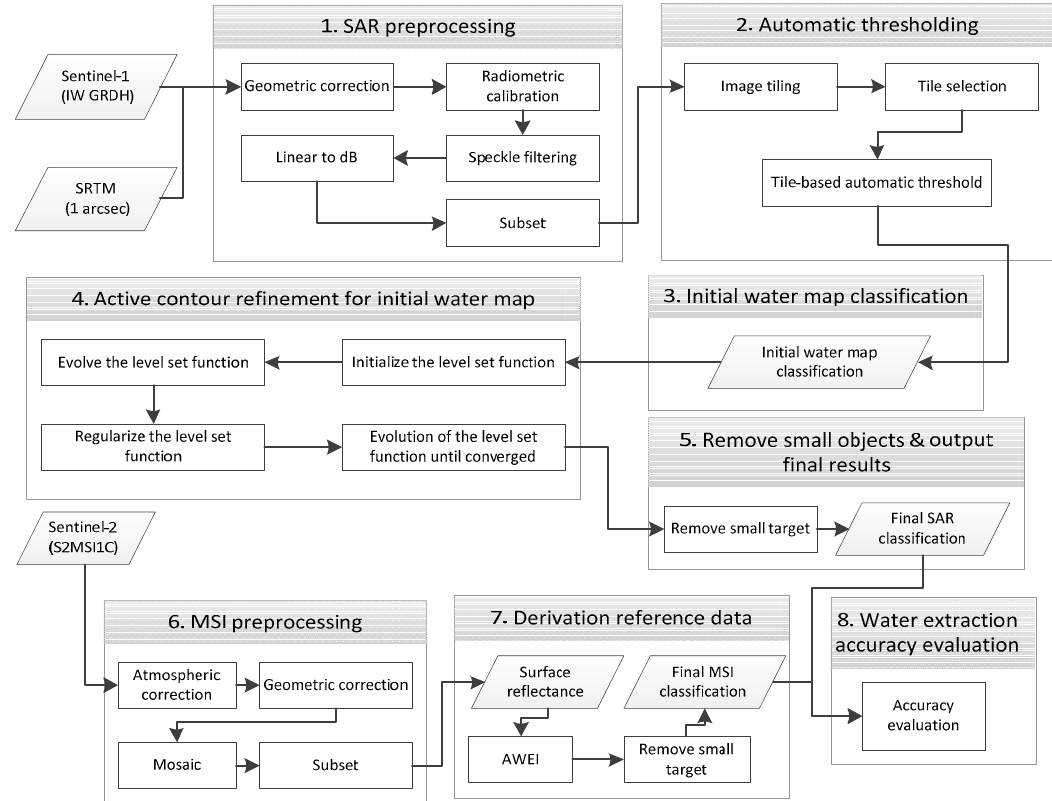
Figure 2. The diagram shows the workflow of the automated water inundation extraction and accuracy evaluation based on Sentinel-1 SAR and Sentinel-2